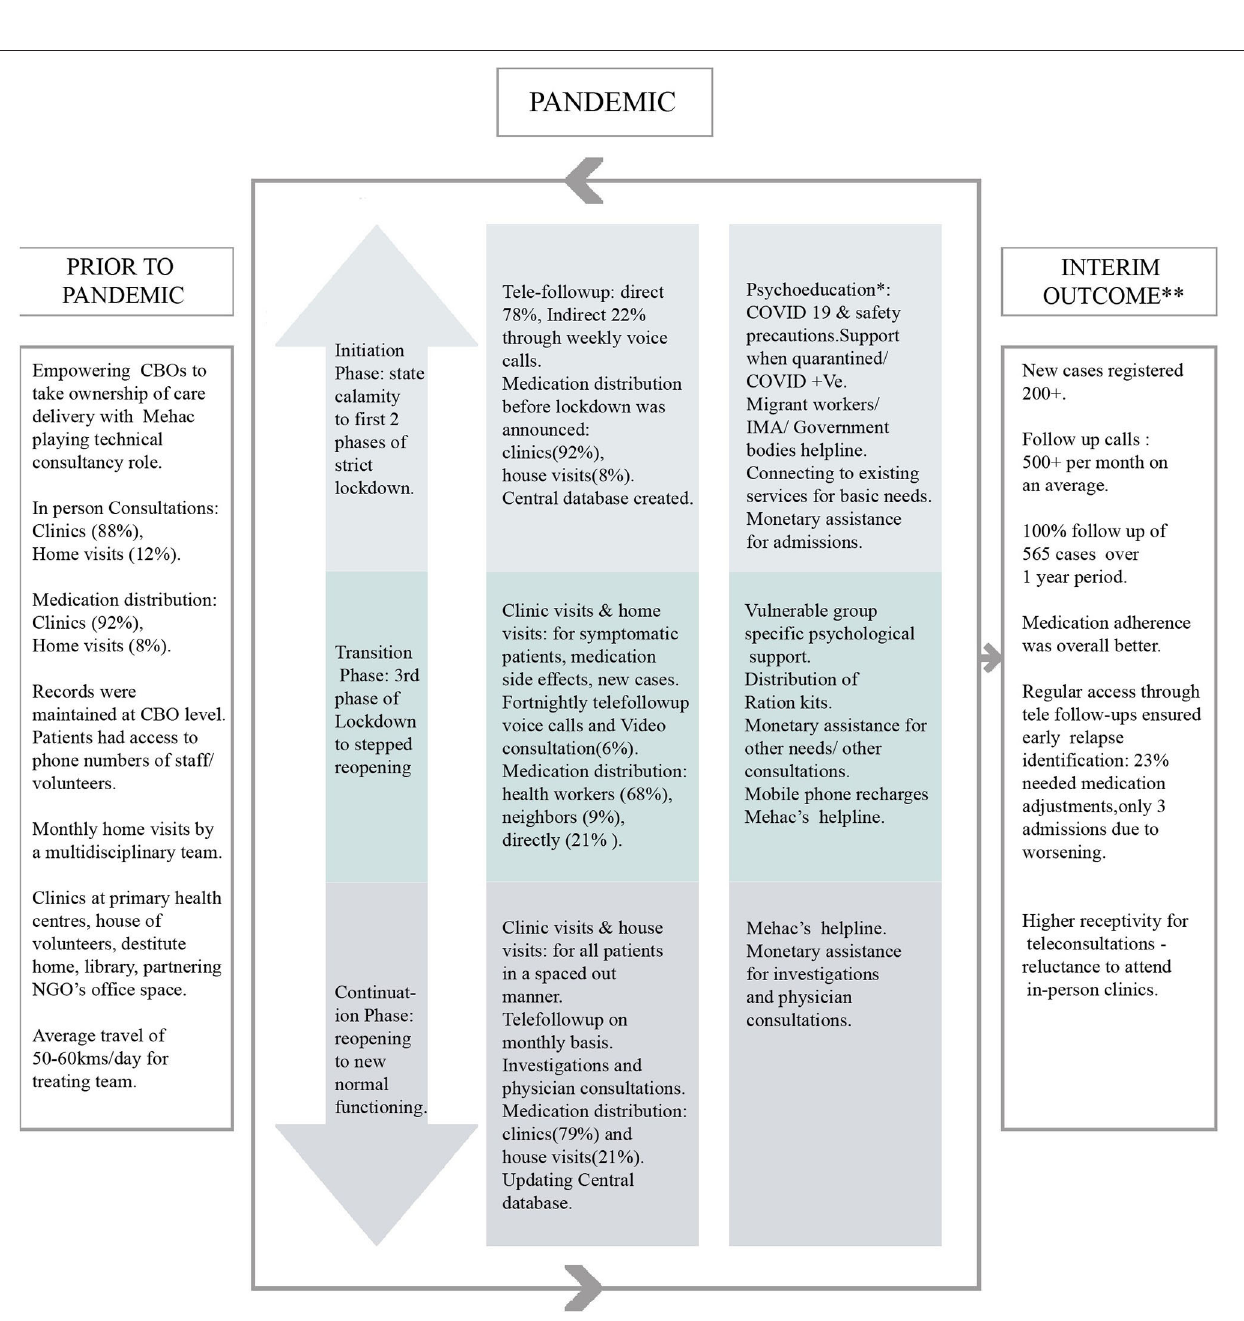
(78%) or indirectly (22%) through volunteers, health workers, or neighbors. Follow up calls were done mainly through voice calls as that was the easily available option to overcome existing digital divide (18). Initial follow-ups were done on a weekly